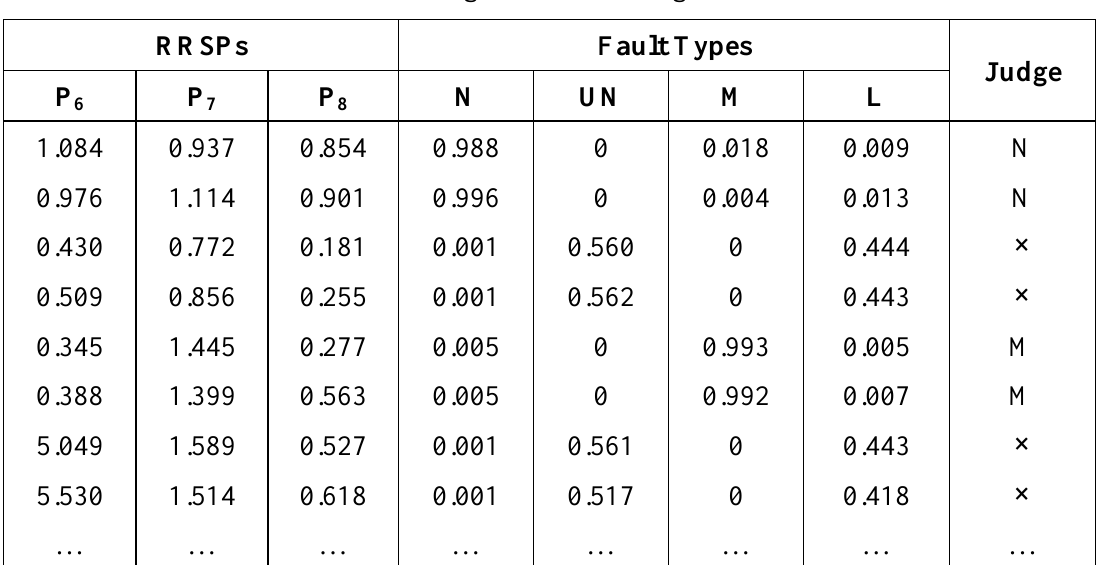
Table 7. Diagnosis result using the